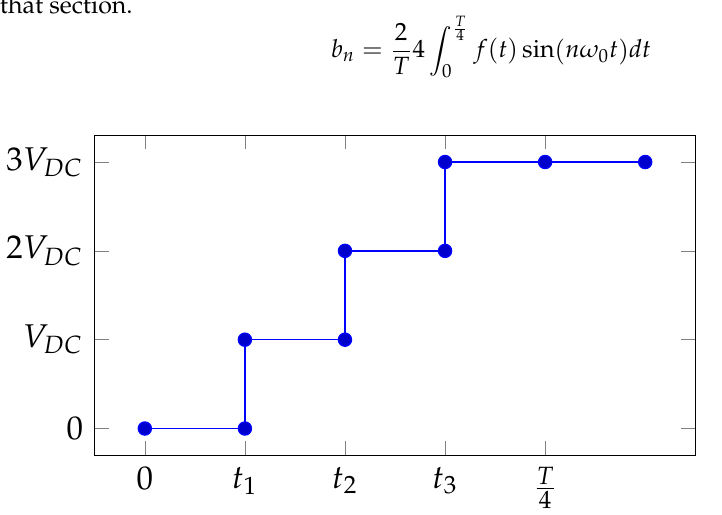
Figure 3. First quarter wave of the example signal